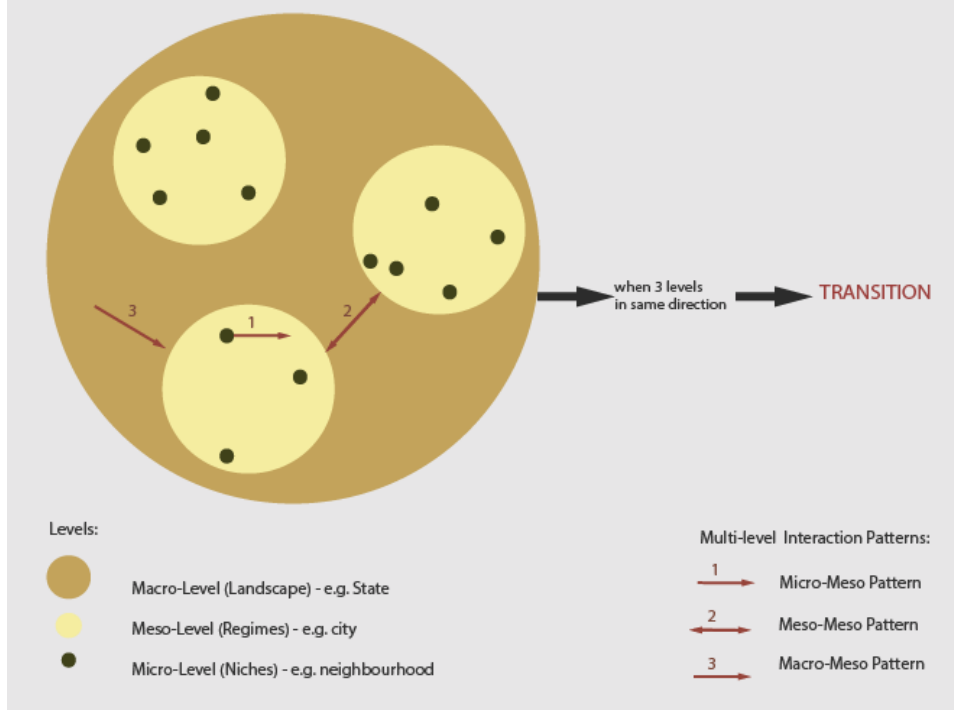
Figure 2. Multi ‐ level perspective. Elaborated by the authors. Figure 2. Multi-level perspective. Elaborated by the